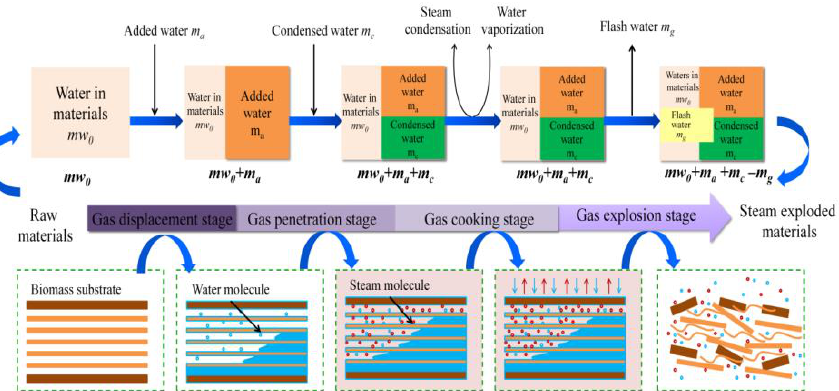
Figure 1. Schematic diagram of steam explosion process [56]. Reproduced with permission from Wenjie Sui and Hongzhang, Industrial Crops and Products; published by Elsevier, 2015.